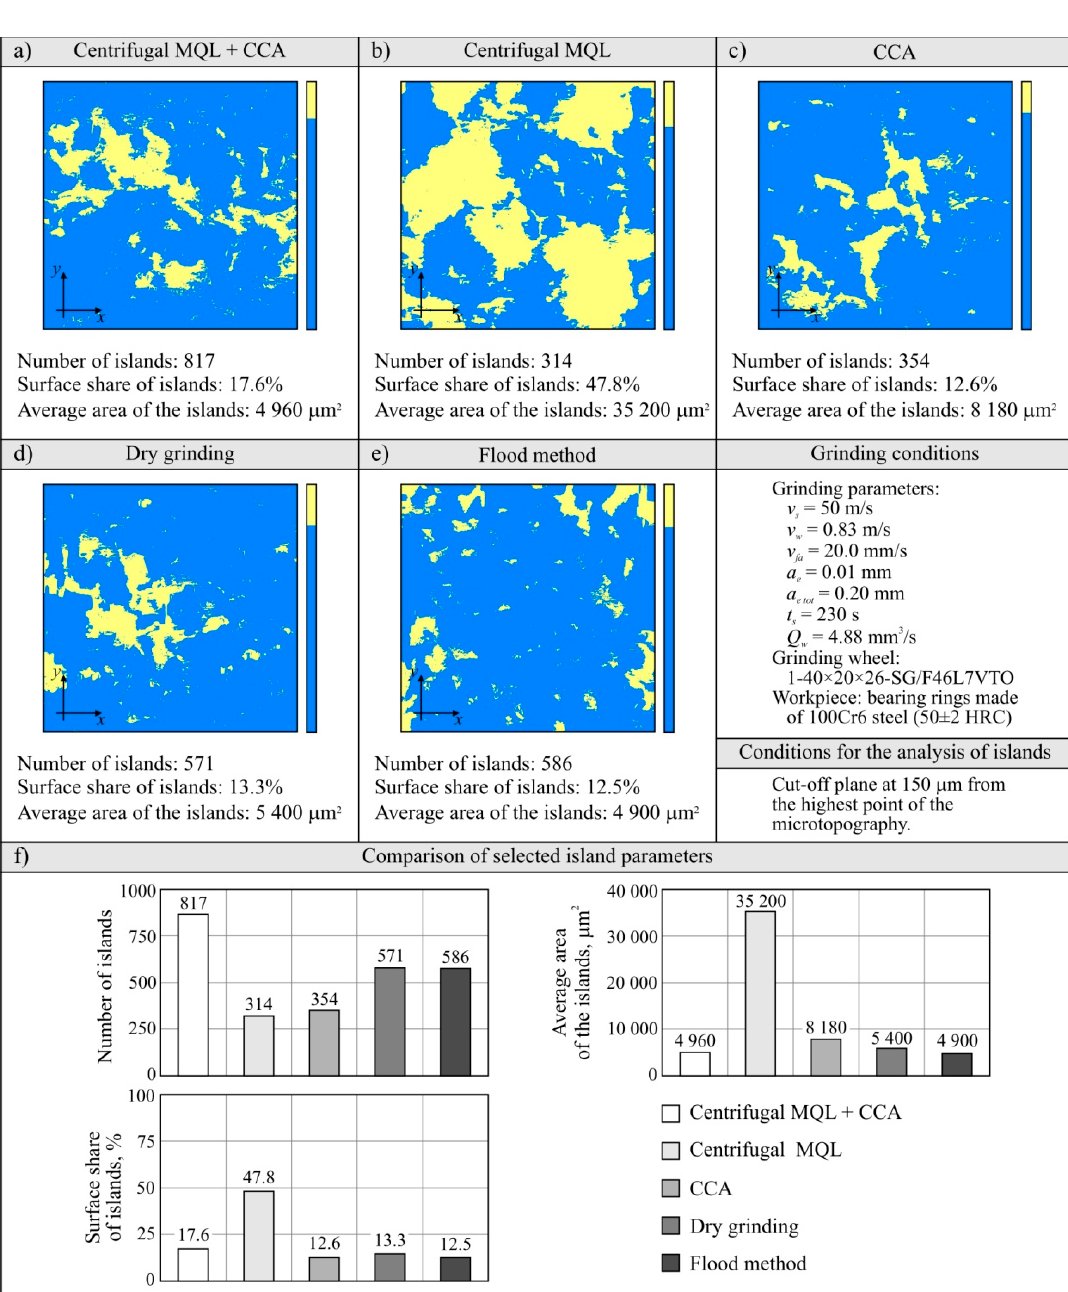
Figure 11. Results of an island analysis (number and area of islands) separated on the GWAS ( a – e ), as well as comparison of selected island parameters ( f ).